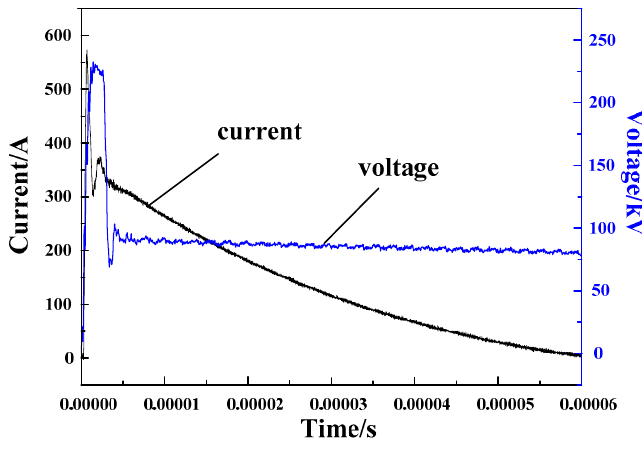
Figure 3. Typical waveforms of voltage and current.